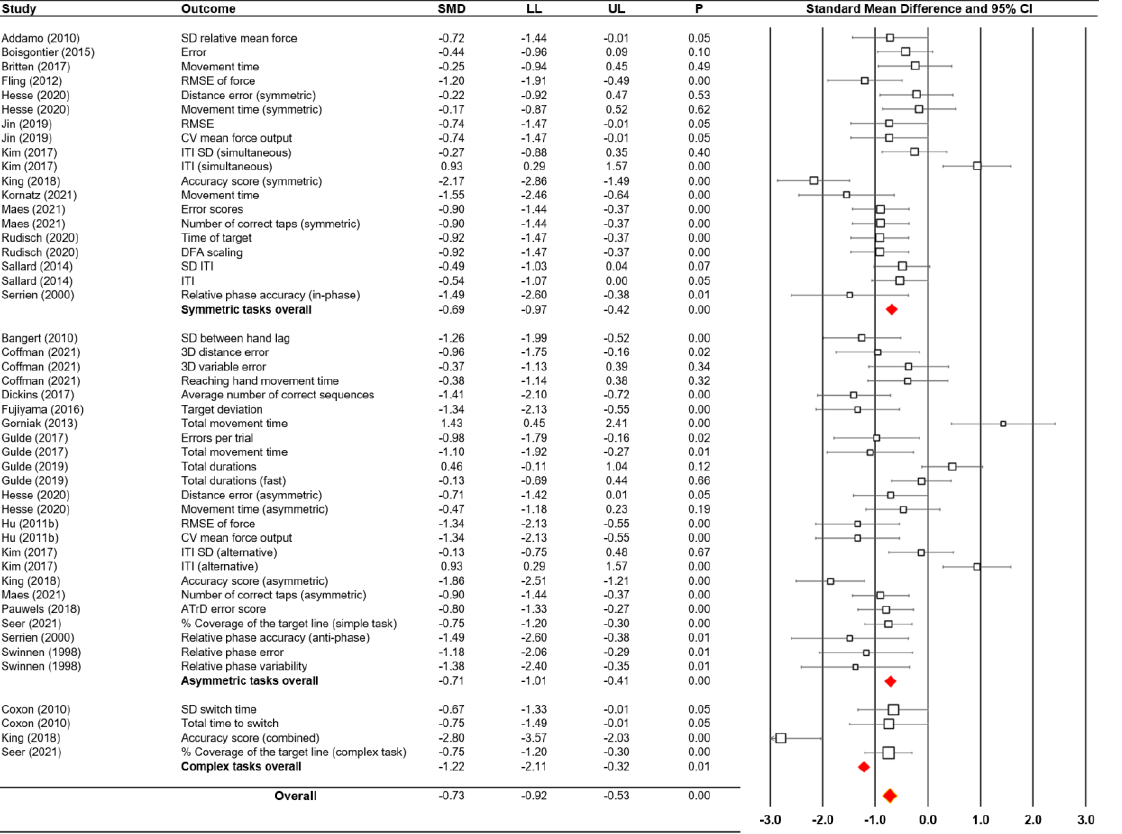
Figure 3: Moderator variable analysis findings on different task types and forest plot for bimanual motor performance in older adults versus younger